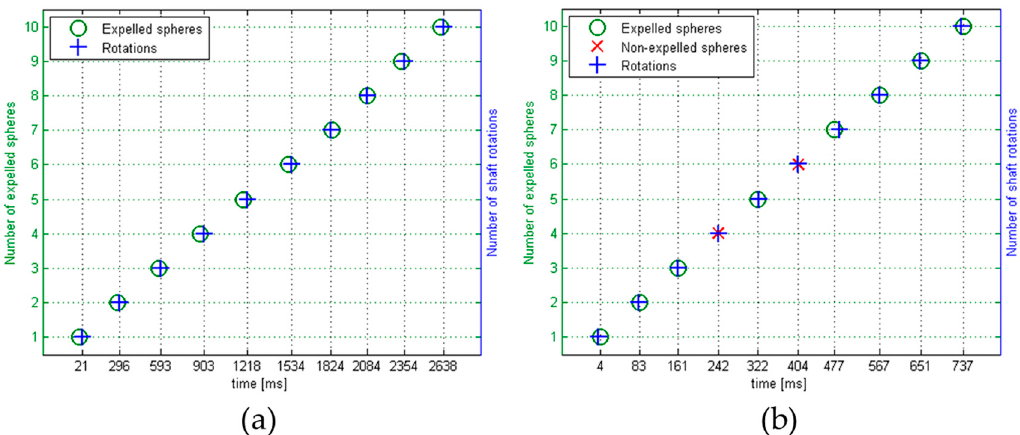
Figure 7. Plots of two reliability tests at different actuator speeds: ( a ) the test at 3.6 revolutions/s with 10 over 10 expelled micro-spheres; and ( b ) the test at 12.5 revolutions/s with eight over 10 expelled micro-spheres.